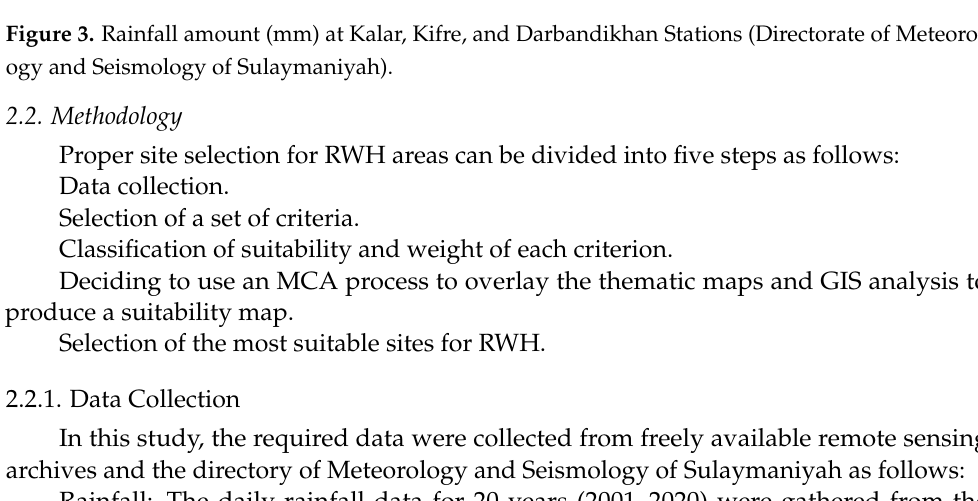
Figure 3. Rainfall amount (mm) at Kalar, Kifre, and Darbandikhan Stations (Directorate of Meteorology and Seismology of Sulaymaniyah).